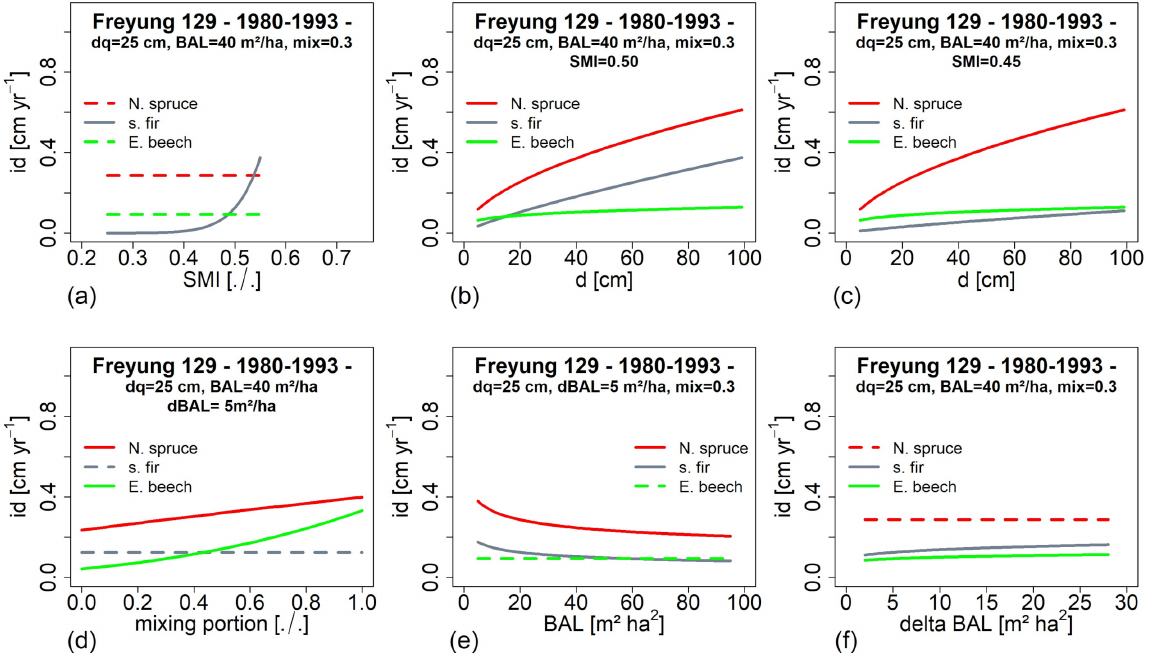
Figure 10. Stem diameter growth, id , of Norway spruce, silver fir, and European beech on the selection forest experiment Freyung 129 in the period with high atmospheric SO 2 -load (1980–1993). Visualized is the modification of id by ( a ) Soil Moisture Index, ( b ) stem diameter growth in periods with SMI = 0.50, ( c ) stem diameter growth in periods with SMI = 0.45 ( d ) mixing portion in the neighborhood, ( e ) local stand density, and ( f ) density reduction by selection cutting (according to Model 6a, see Table 4). Broken lines indicate non-significant, invariant